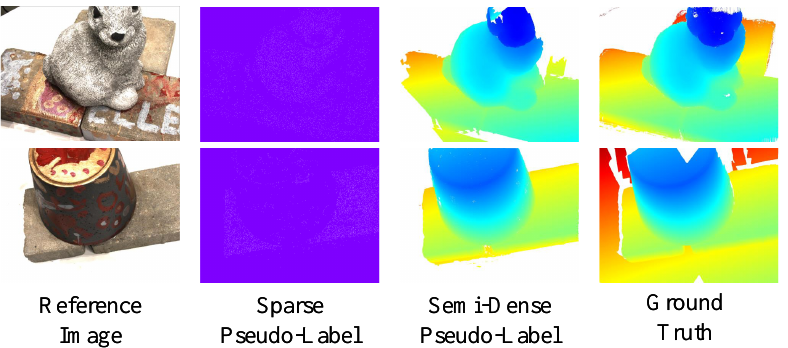
Figure 9. Visualization of different pseudo-labels.